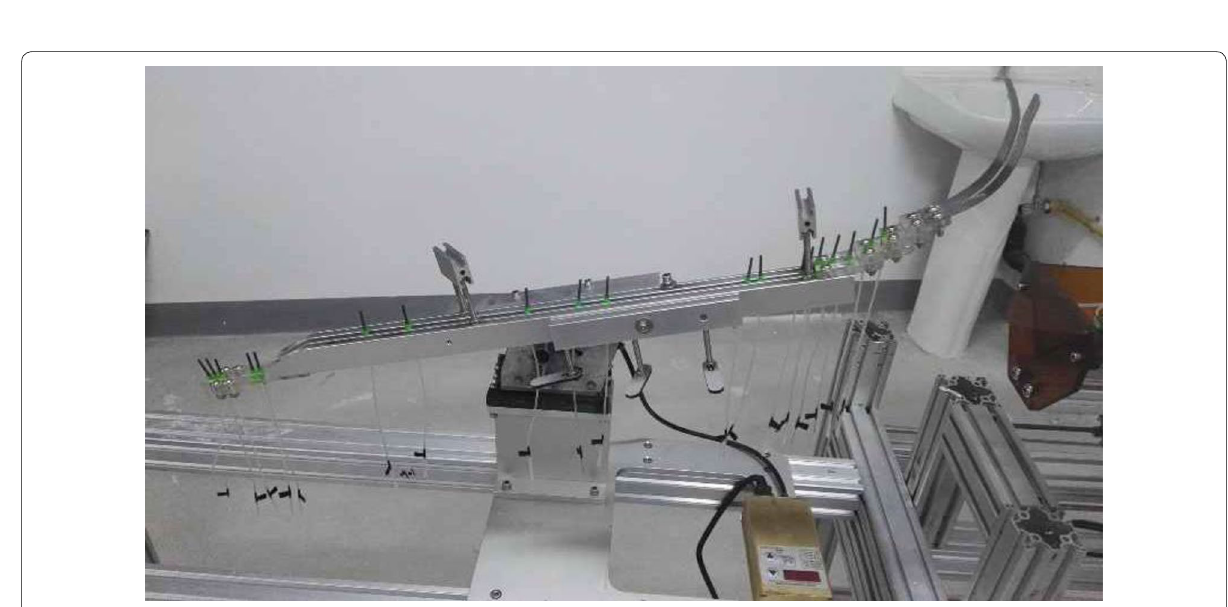
Figure 10 Automatic sorting and conveying test